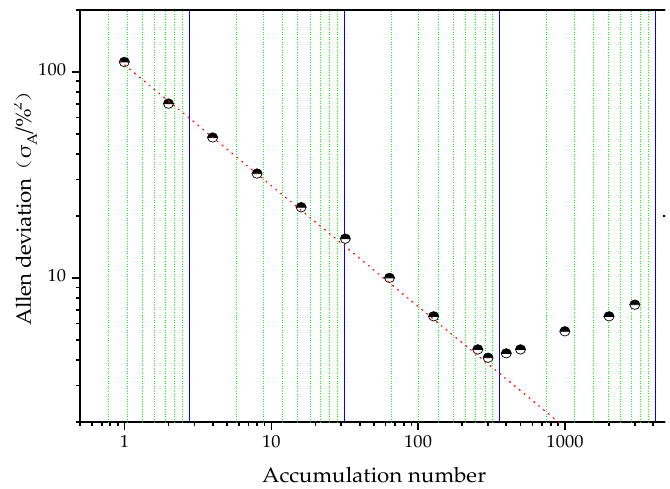
Figure 7. The log–log plot for Allan deviation of Raman intensity of 891 cm − 1 versus accumulation number.